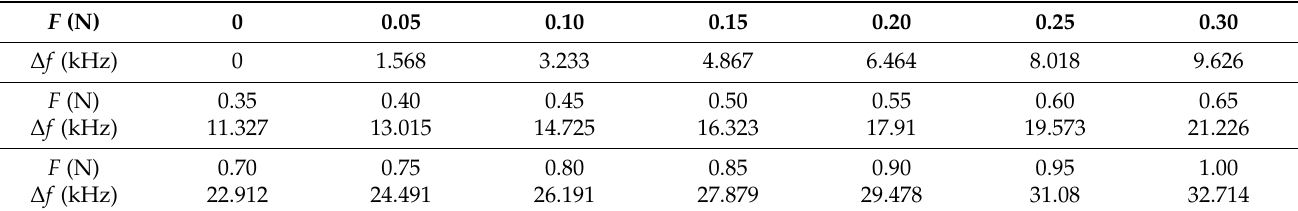
Table 2. The data of the calibration experimental.